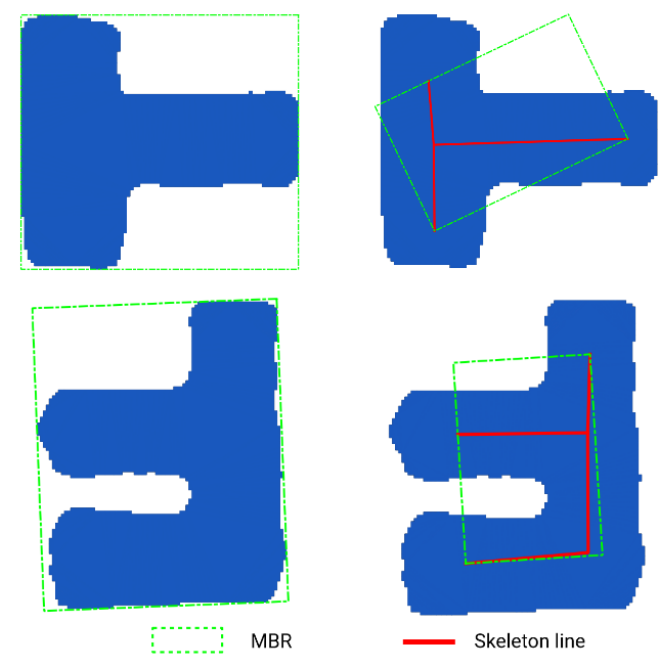
Figure 20. MBR for buildings and skeleton lines.